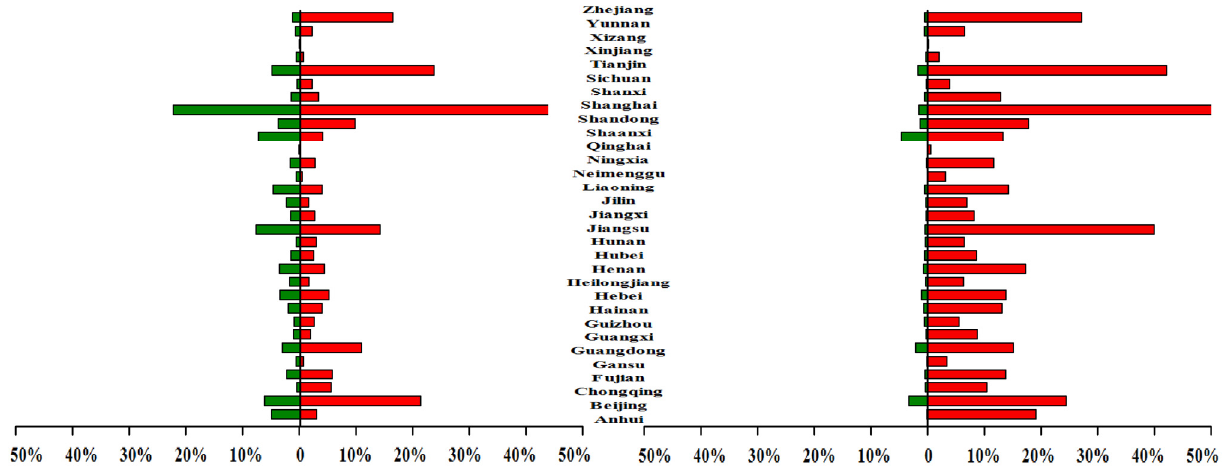
Figure 6. Percentage of land surface area increasing (red) or decreasing (green) in brightness (1992–1996 to 2000–2004 on the left, 2000–2004 to 2008–2012 on the right; provincial regions except Hong Kong, Macau and